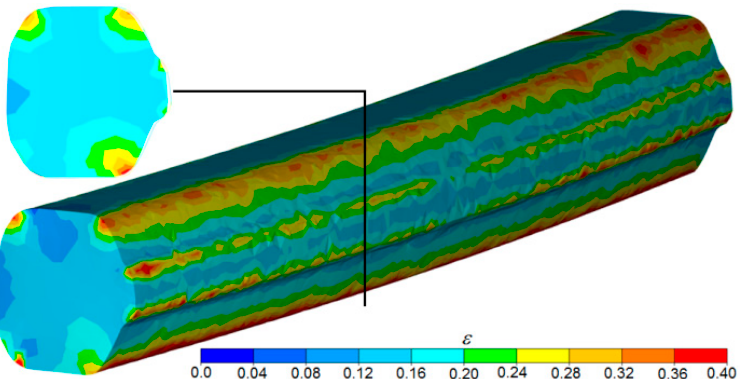
Materials 2019 , 12 , x FOR PEER REVIEW Figure 6. FEM strain distribution in the blank longitudinally rolled in the groove pass.